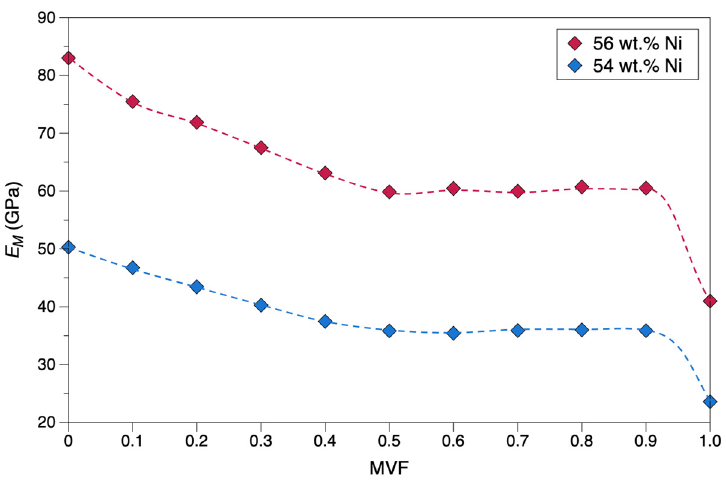
Figure 19. Effect of martensite phase evolution on the stiffness of NiTi for the two Ni contents.